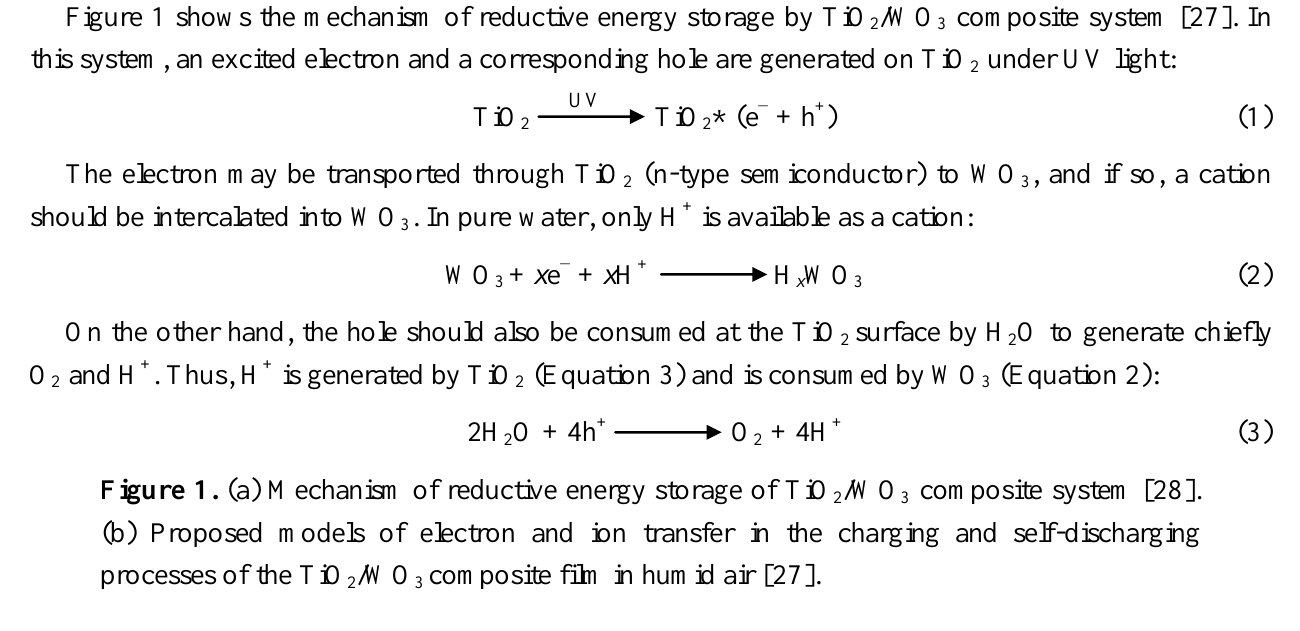
/WO composite system [28]. 2 3